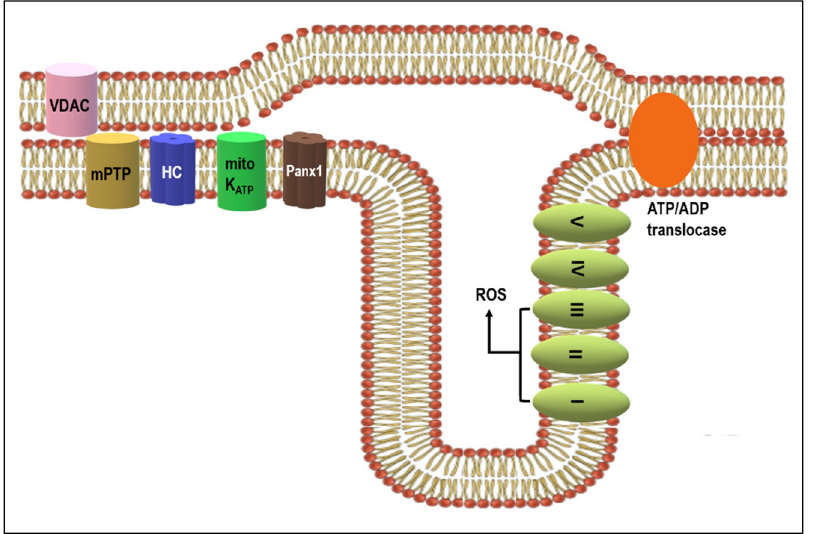
Figure 3. Diagram illustrating possible implication of putative mitochondrial HCs and Panx1 channels in cardioprotective signaling pathways promoting the opening of K ATP channels and hampering the mitochondrial permeability transition pore (mPTP). This may result in the prevention of Ca 2+ overload, excessive levels of ROS and decline in ATP production. For details, see text and references [187,202].